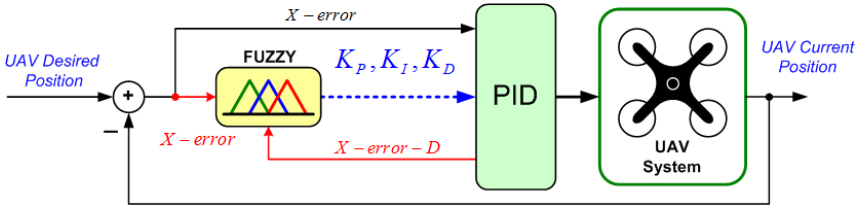
Figure 1. Scheme of fuzzy addition to the PID